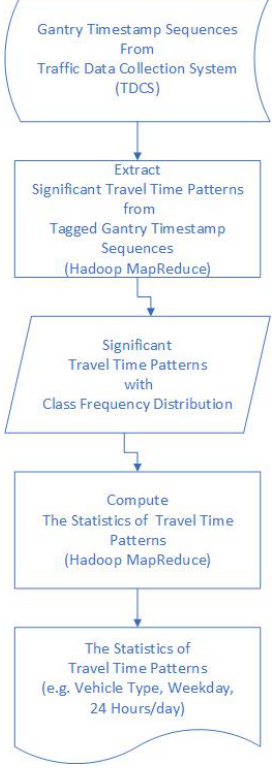
Figure 6. The flowchart of extracting significant travel time patterns and computing the statistics of these